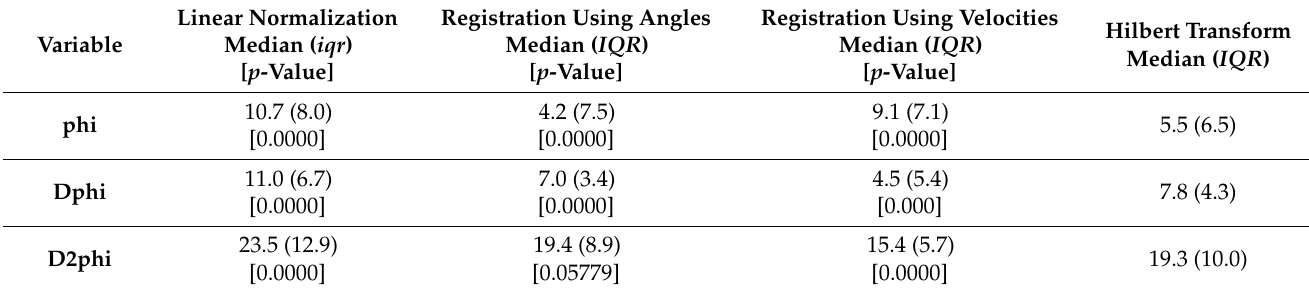
Table 2. Distribution of the phase difference between the individual curves of angles (phi), angular velocities (Dphi), and angular accelerations (D2phi), and their corresponding functional means, for each time-scale normalization method. The median and interquartile range are measured in degrees. The level of significance of the comparison of each normalization method with the Hilbert transform, using Friedman’s test, is presented in